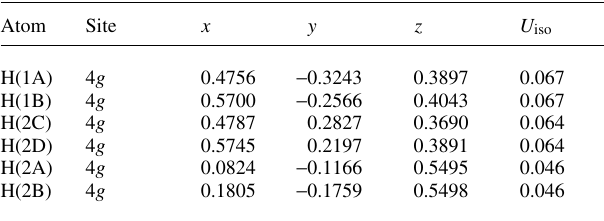
Table 2. Atomic coordinates and displacement parameters (in Å 2 )